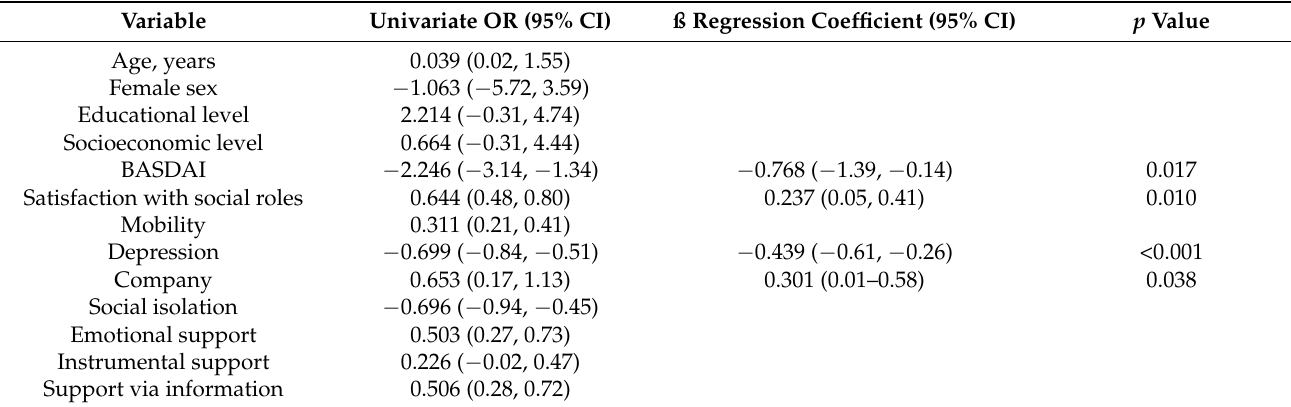
Table 5. Multivariable linear regression analysis of the characteristics associated with ability to participate in social activities in patients with SpA.